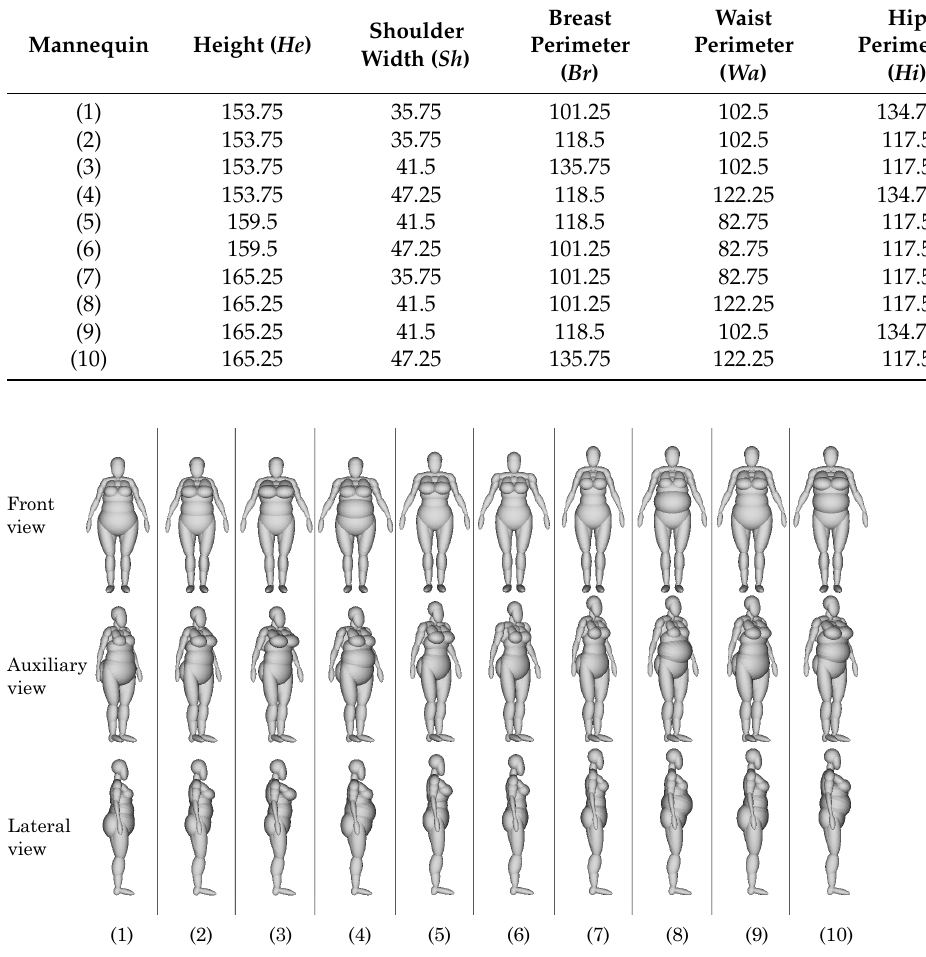
Figure 18. Examples of synthesized ellipsoid-based mannequins using segmented interpolation approach.